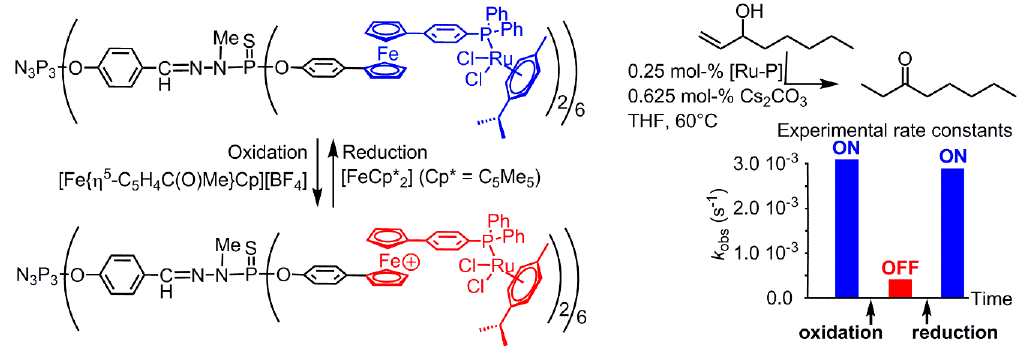
Figure 15. Isomerization of 1-octen-3-ol carried out with a catalytic amount of ferrocenylphosphino-Ru complex of dendrimer. Switch ON/OFF/ON experiments and influence on the catalytic activity.